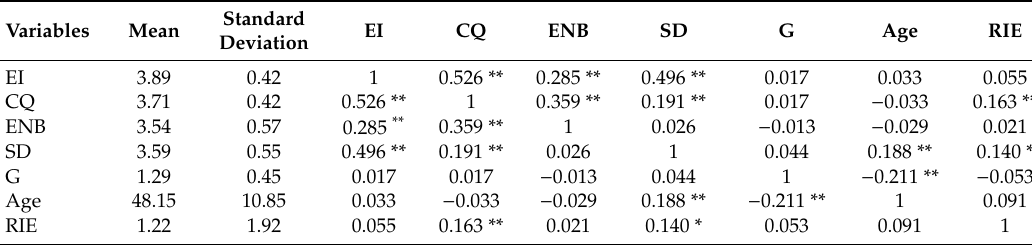
Table 4. Descriptive statistics and